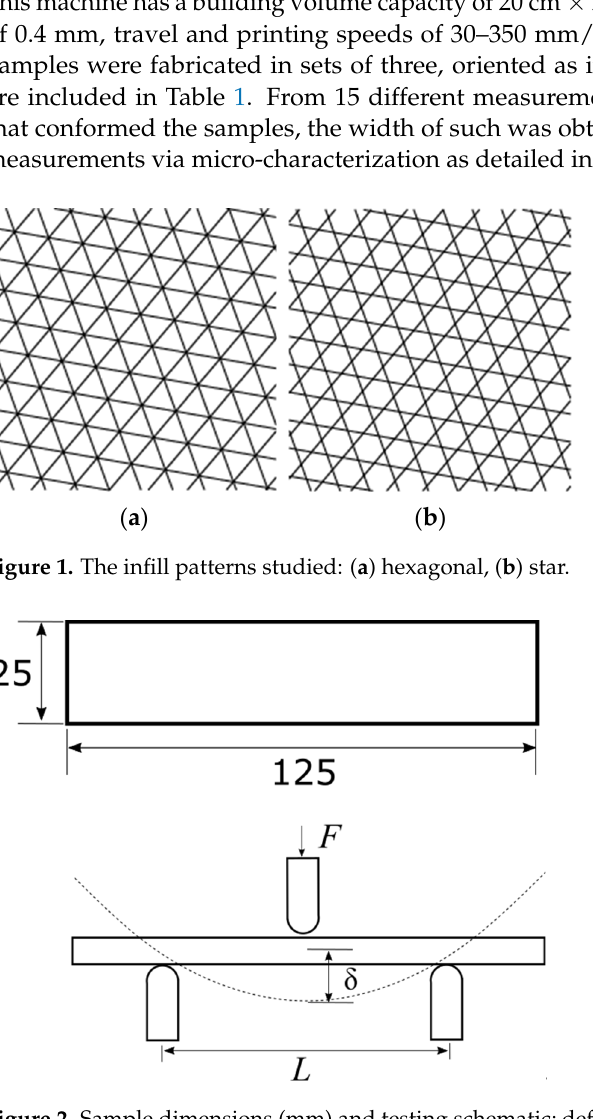
Figure 2. Sample dimensions (mm) and testing schematic; deformed shape is presented with dotted line. Thickness of the samples is 6 mm.